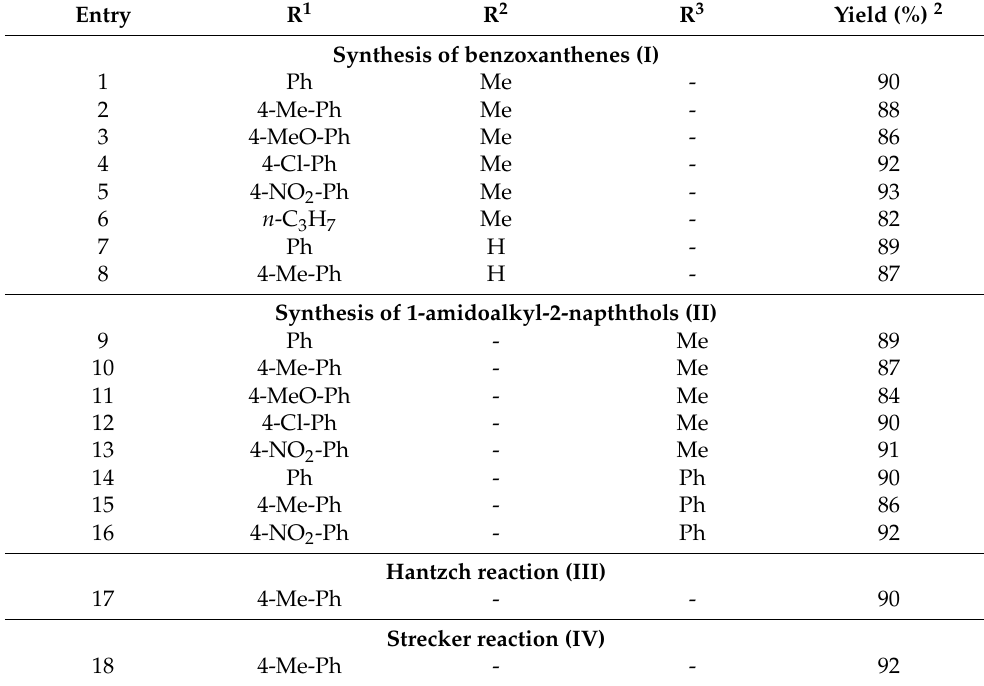
Table 1. LSA -catalyzed one-pot MCR [31] 1